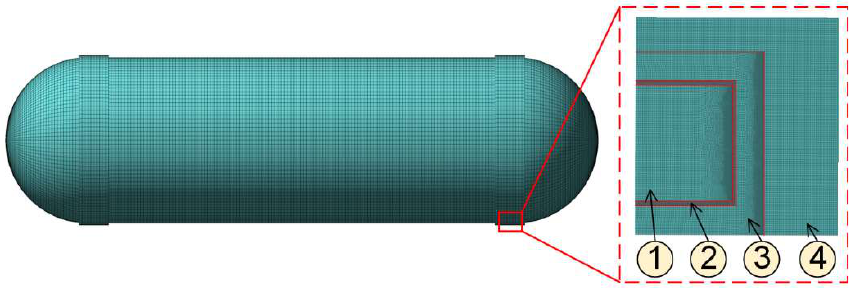
Figure 4. The mesh of a ceramic pressure housing with “Symmetry”, (1) ceramic shell, (2) epoxy resin adhesive, (3) mental U-ring and (4) metal end-cap.